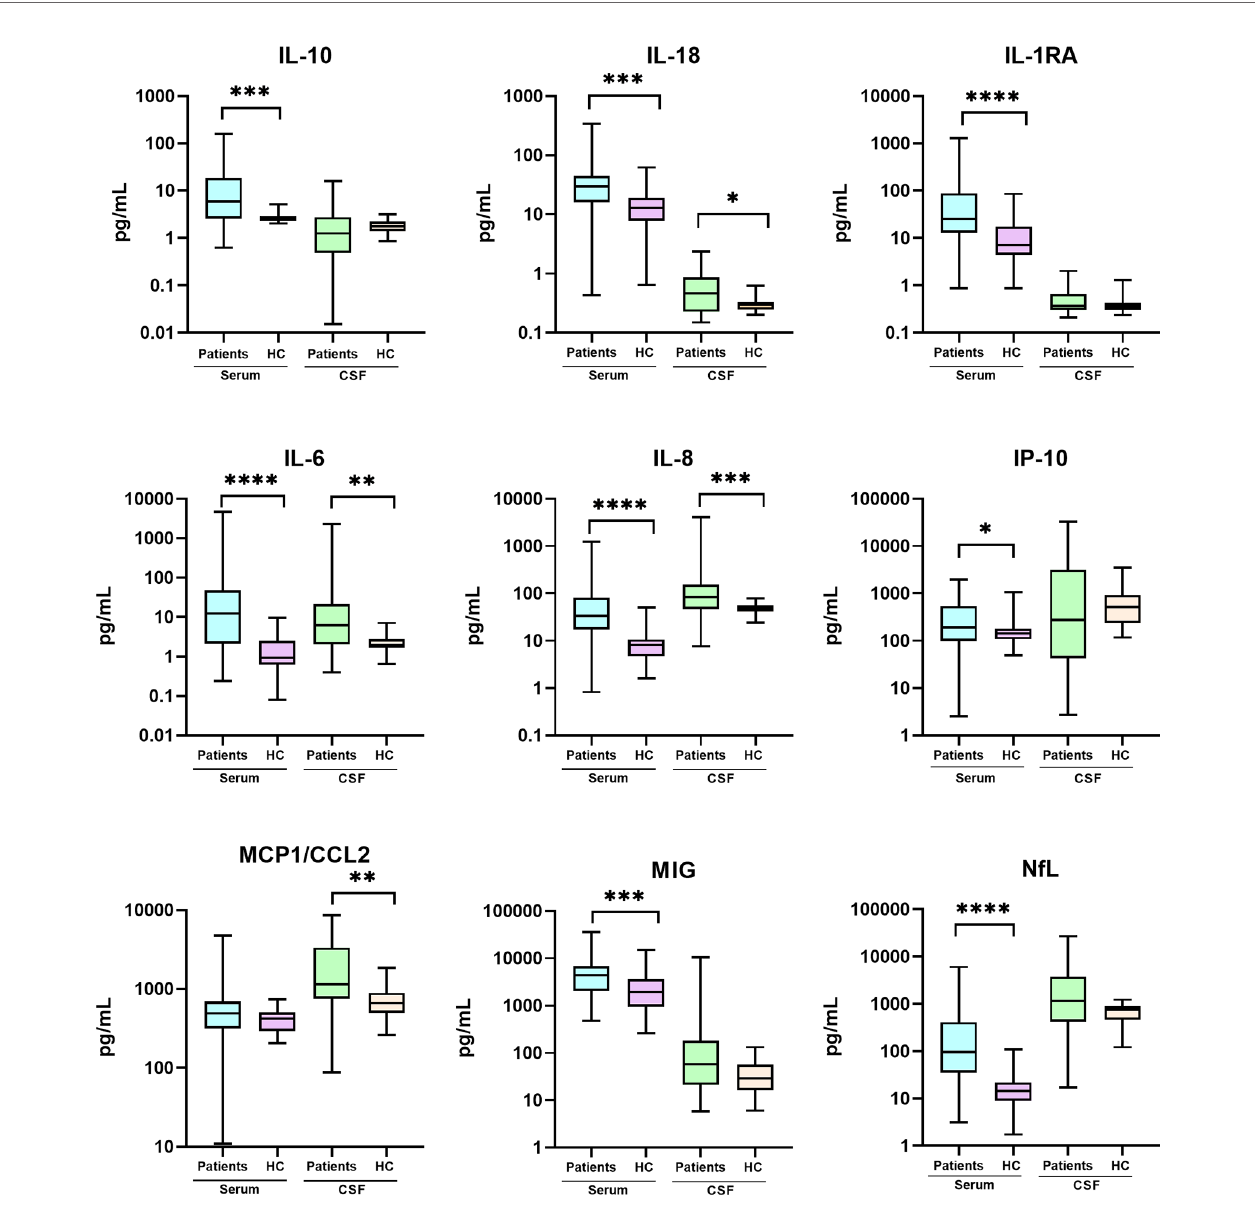
FIGURE 1 | Cytokine and NfL levels in the CSF and serum of patients with COVID-19 and neurological manifestations compared with healthy controls (HC). Comparative analyses were performed using Mann-Whitney U test. CSF, cerebrospinal fl uid; IL, interleukin; IP, IFN- g – induced protein; MCP, macrophage chemoattractant protein; NfL, neuro fi laments; MIG, monokine induced by interferon (IFN)-gamma. (*) p<0.05; (**) p<0.01; (***) p<0.001; (****)